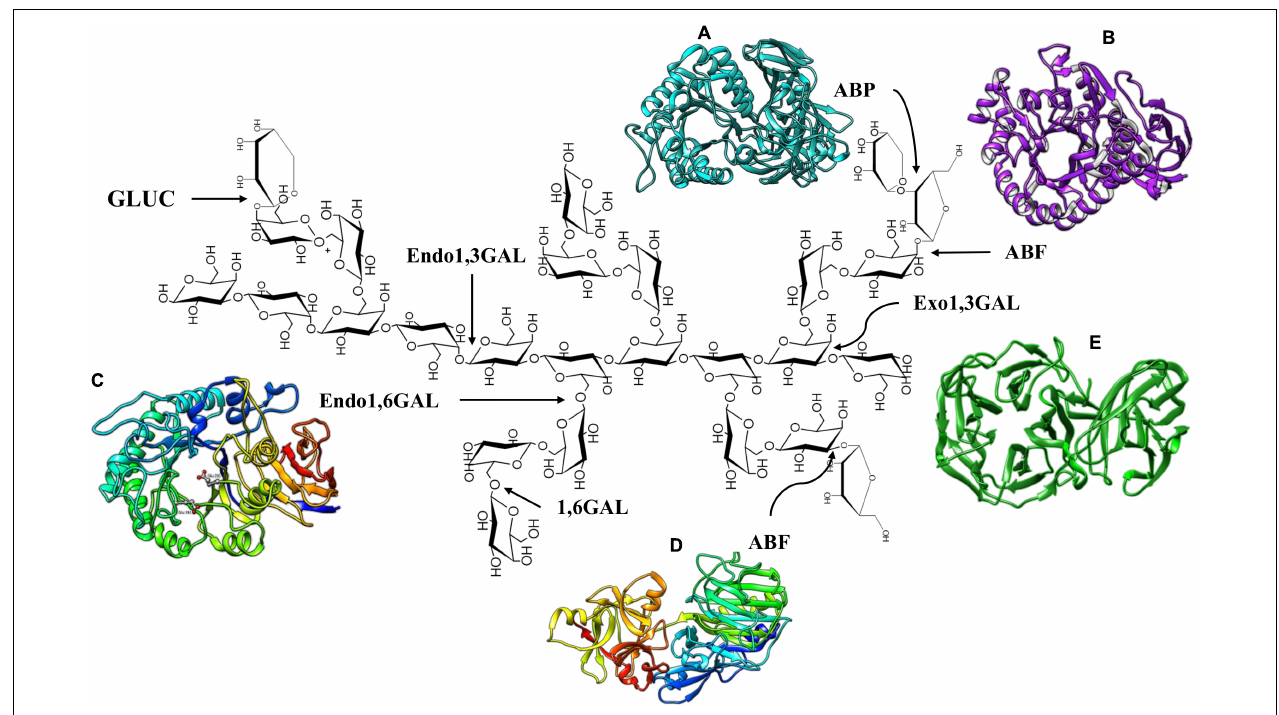
FIGURE 2 | Enzymes that degrade AG Type II. (A) S. avermitilis ABP, PDB code: 3A21. (B) Thermobacillus xylanolyticus ABF GH51, PDB code: 2VRQ. (C) Endo1,6GAL modeling of Colletotrichum lindemuthianum (Villa-Rivera et al., 2017b). (D) Aspergillus luchuensis ABF GH 54, PDB code: 1WD3. (E) Phanerochaete chrysosporium Exo1,3 GAL, PDB code: